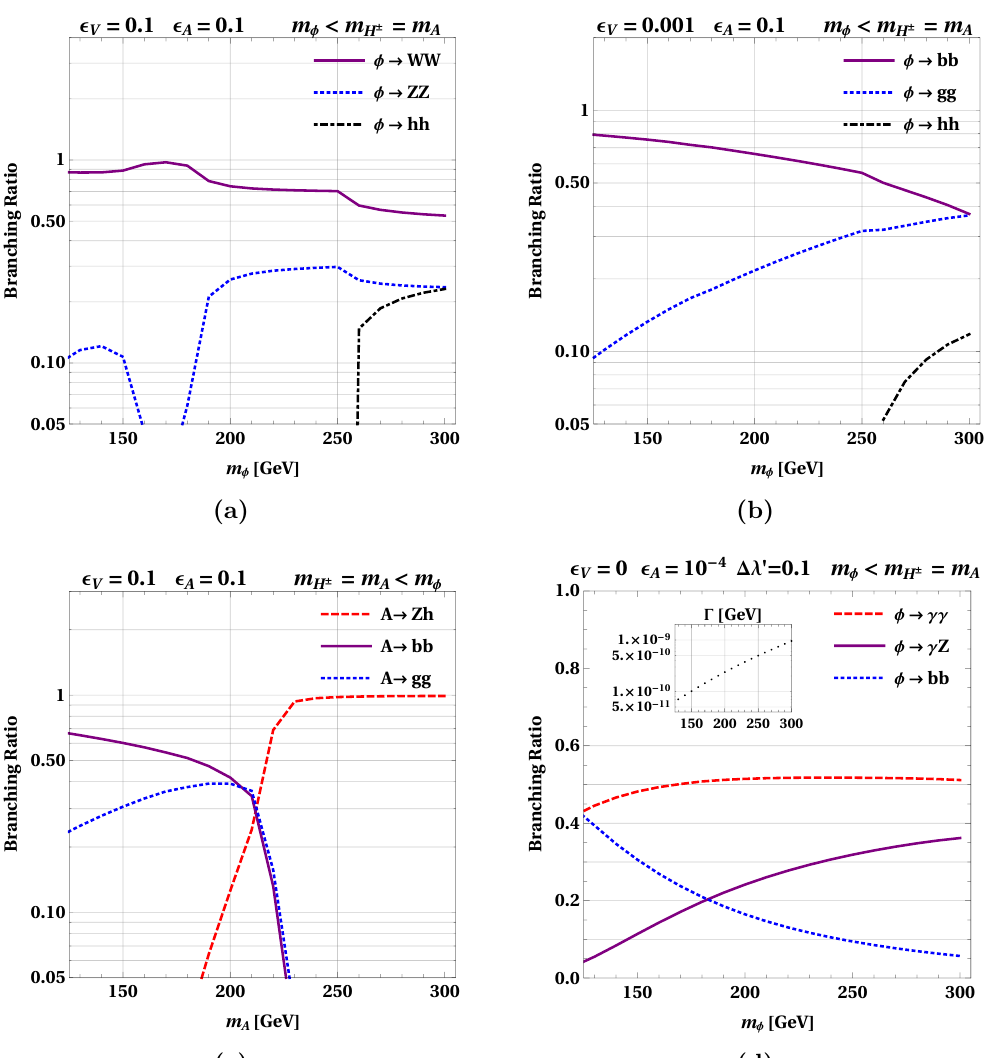
Figure 2. Examples of dominant decay modes of the neutral approximately Z 2 -odd Higgsses as a function of their mass. The small Z 2 breaking parameters (cid:15) V and (cid:15) A roughly control the size of their decays to SM weak gauge bosons and fermions, respectively. The subplot in (cid:12)gure 2d shows that (cid:30) can still undergo a prompt decay even when (cid:15) V (cid:24) (cid:15) A ! 0, via loop induced processes which are controlled by (cid:1) (cid:21) 0